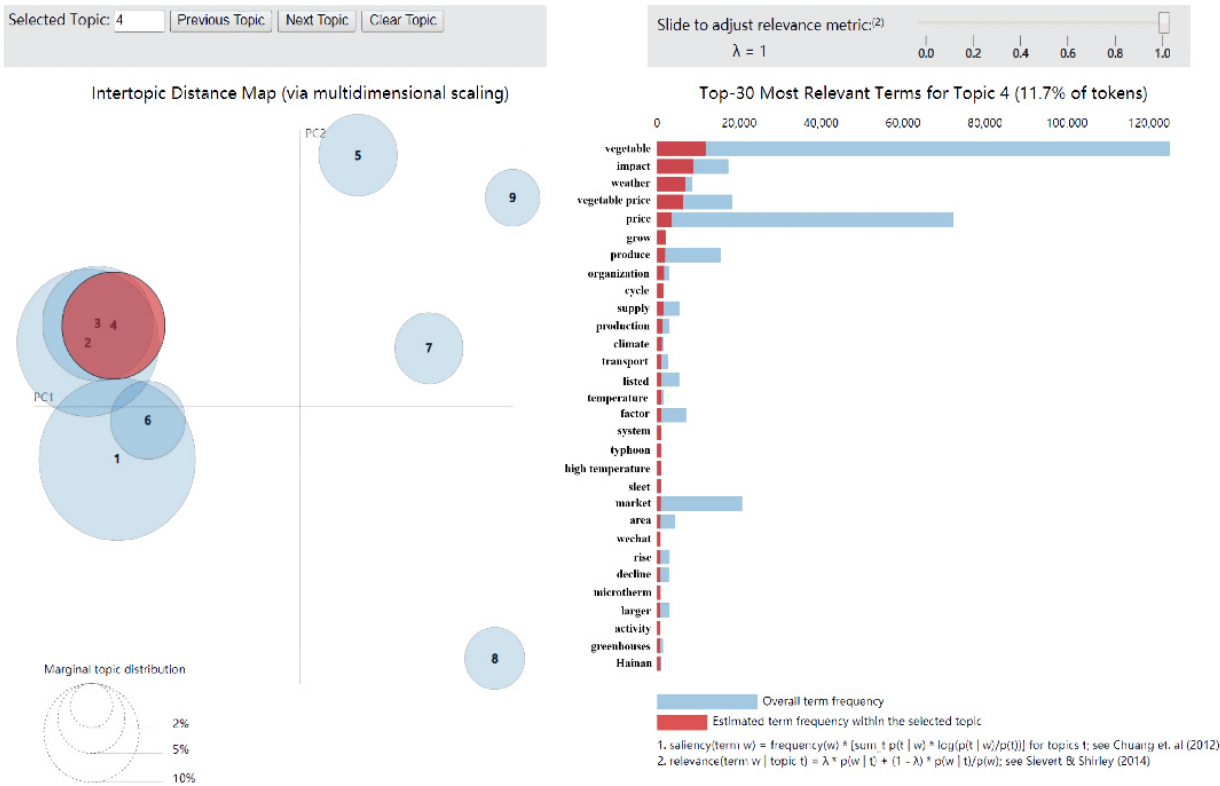
Figure 3. Subject Extraction Visualization.